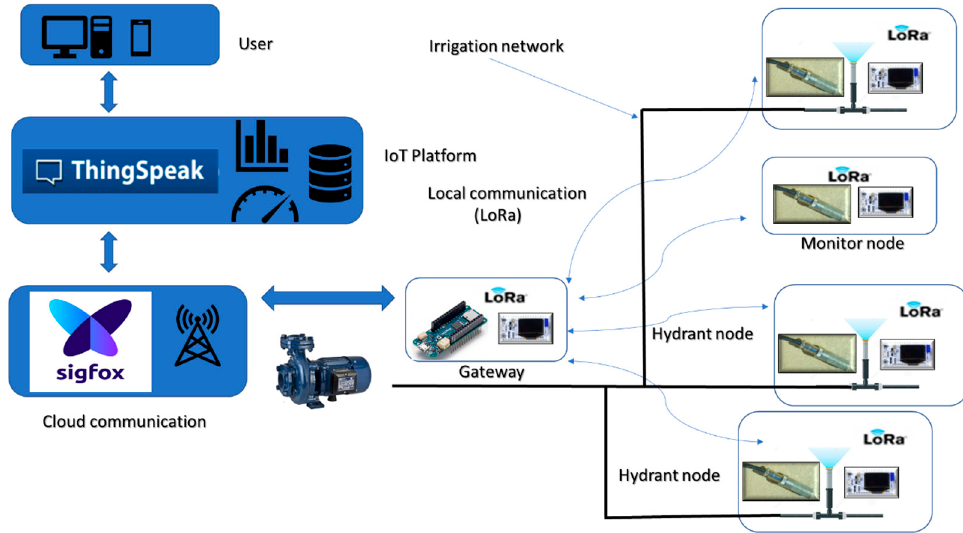
Figure 16. Global system architecture.